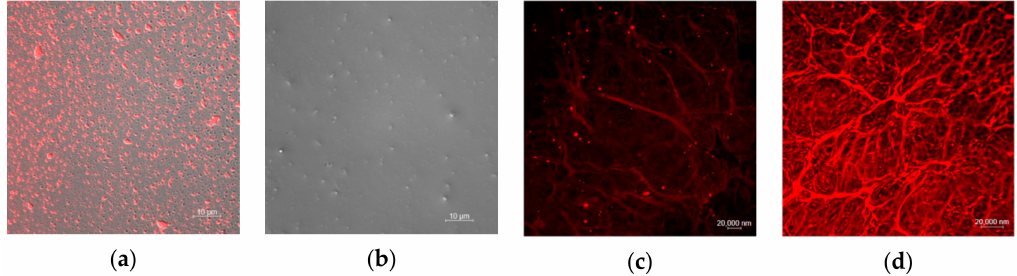
Figure 5. LSCM images of ( a ) protamine–siRNA complexes, ( b ) thermo-responsive phospholipid microcapsules, ( c ) drug-loaded composite hydrogel of thermo-responsive phospholipid microcapsules in concentrations of 0.1 mg mL − 1 , and ( d ) drug-loaded composite hydrogel of thermo-responsive phospholipid microcapsules in concentrations of 0.2 mg mL − 1